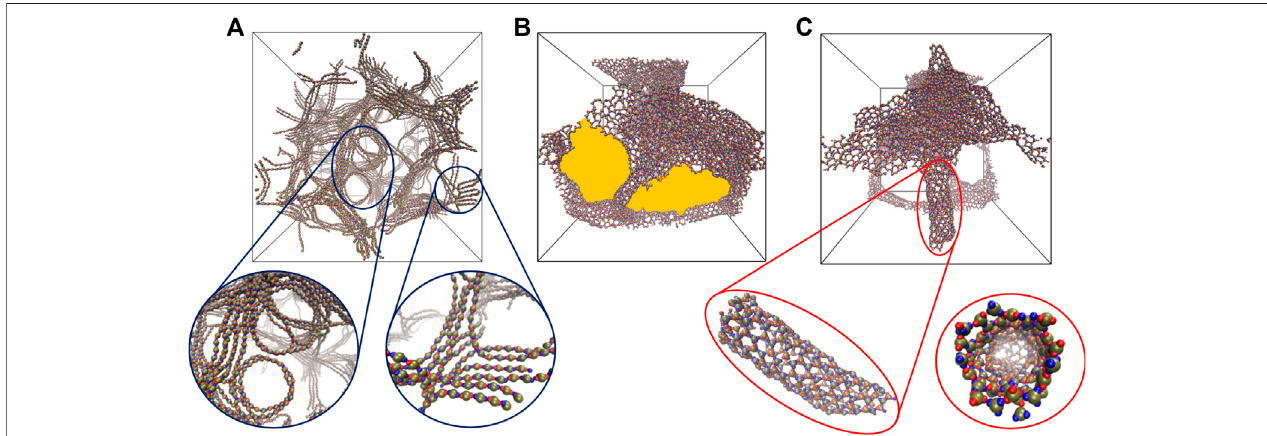
FIGURE 4 | Snapshots highlighting self-assembled networks formed by the particles with two ( S DB 2 ) or three ( S TP 3 ) lobes. (A) Interconnected chain-like morphologiesformedbythe S DB 2 particles;and (B,C) randomaggregatesandhollowcylindricalmorphologiesformedbythe S TP 3 particles.Theblueandredcirclesshow zoomed-in views, and a yellow patch (panel B) represents intra-network pore